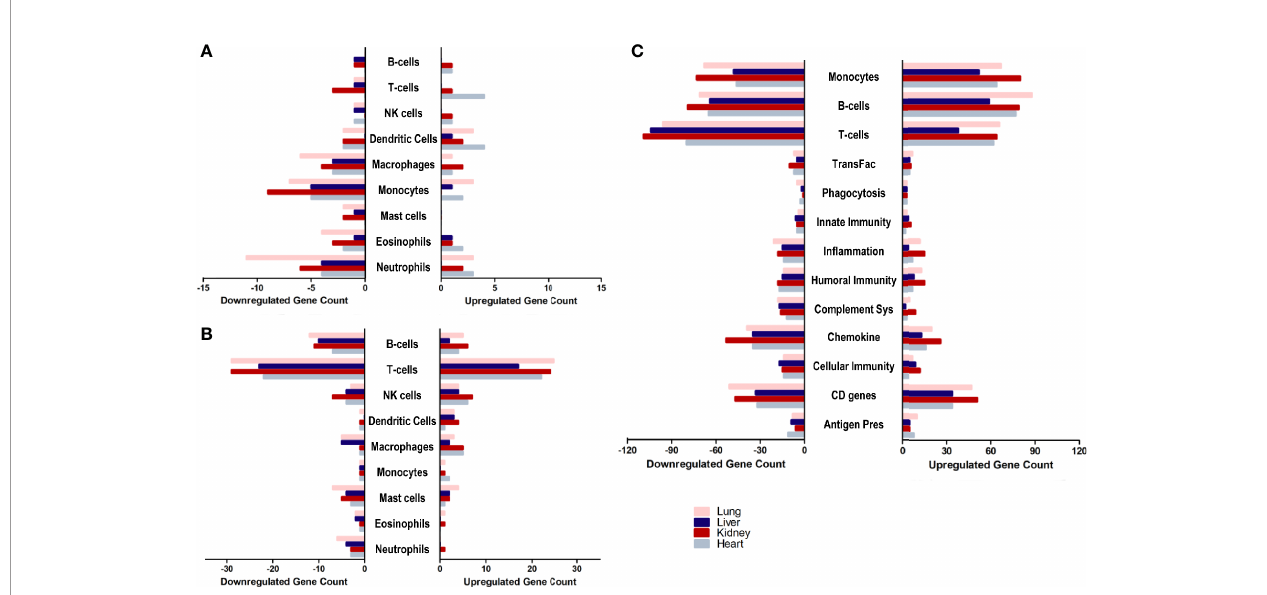
FIGURE 3 | The count of differentially expressed genes in SARS-CoV-2 infected lung, liver, kidney, and heart tissues overlapping with the (A) immune cells chemotaxis gene ontology set, (B) immune cells activation gene ontology sets, and (C) Immunome gene ontology set ontology